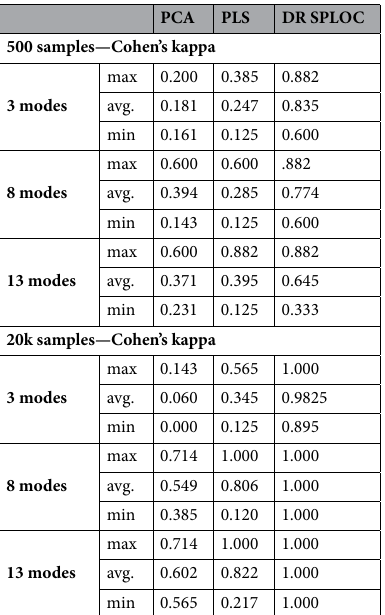
Table 1. Cohen’s kappa statistic for intra-rater reliability against ground truth at 500 and 20k